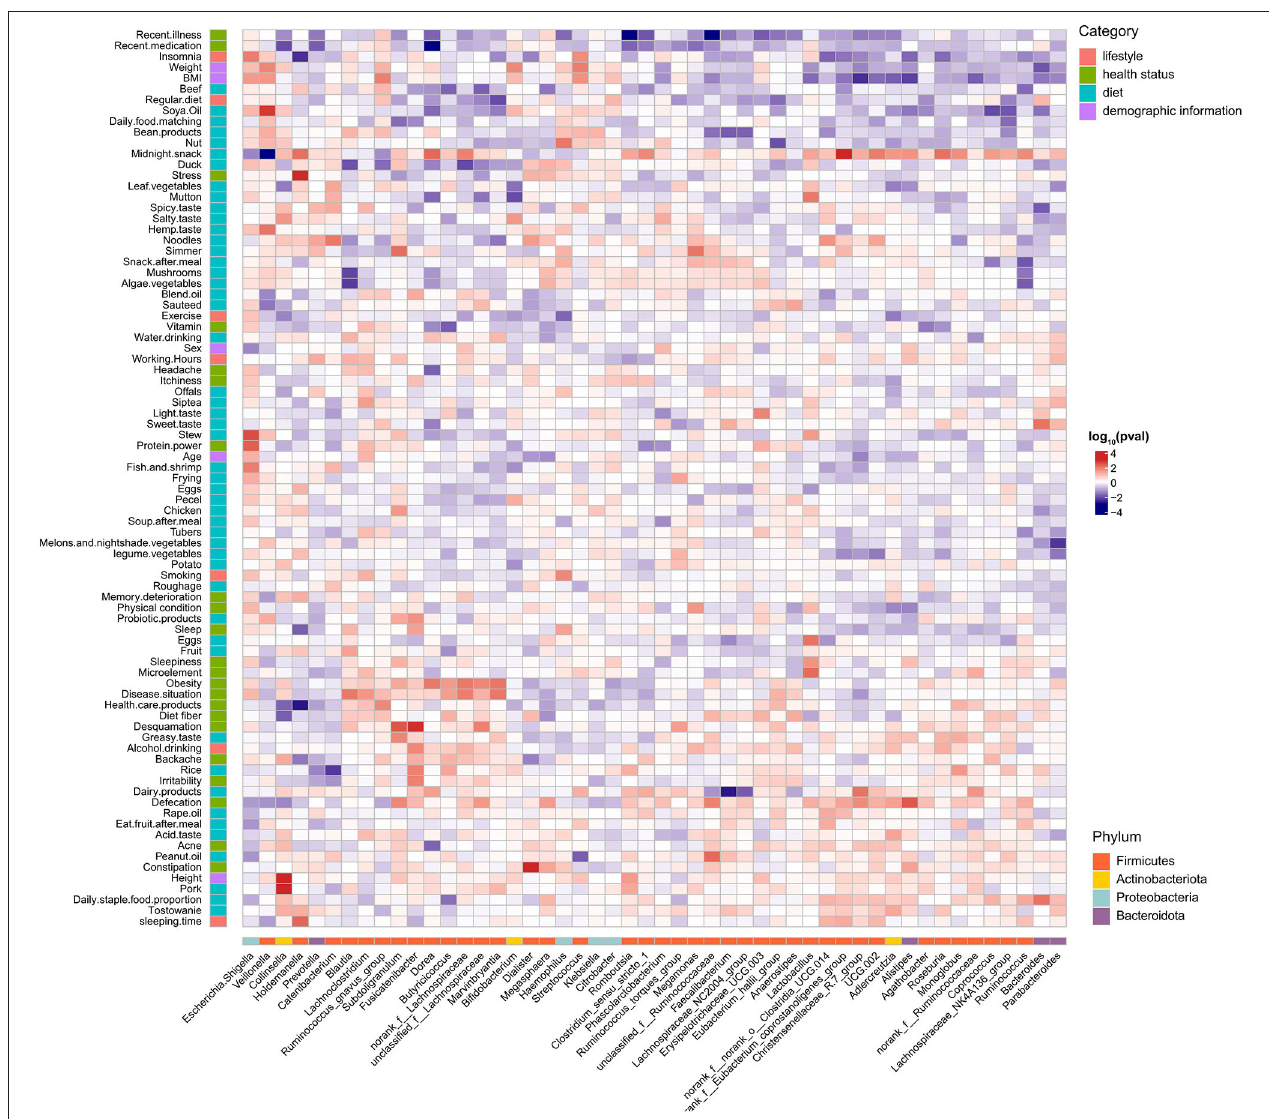
FIGURE 5 | Associations between microbial genera and multiple factors. Shown is a heatmap of the microbial genera (x-axis) that were found to be significantly associated with different factors (y-axis) using generalized linear models adjusted for confounding factors. The significant heatmap cells are represented by the direction of association (indicated by color, e.g., red is positively associated). Each factor is colored by the category to which it belongs, and each genus is colored by the phylum to which it belongs.